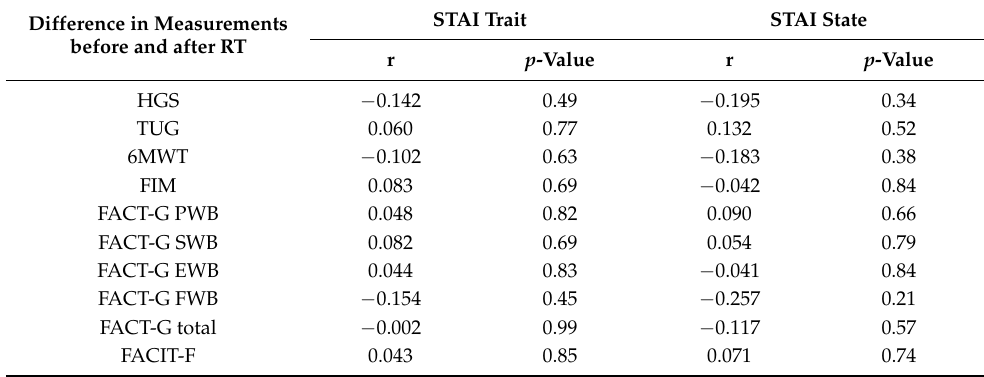
Table 8. Correlations between differences in outcomes before and after RT and anxiety